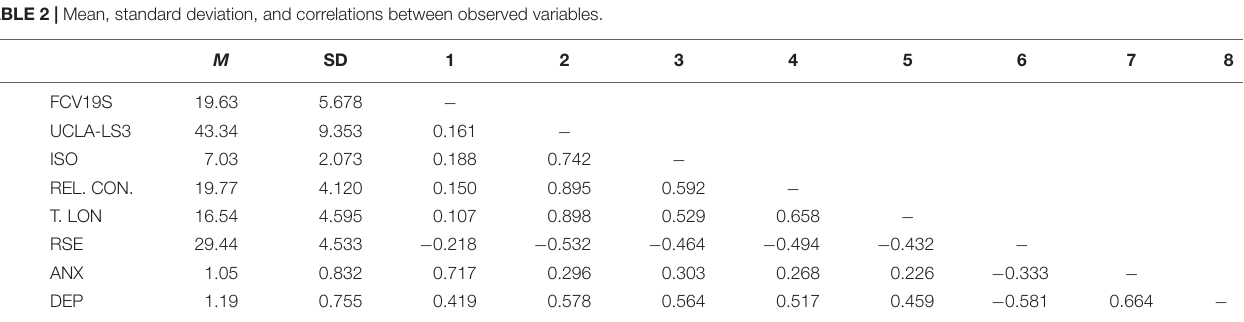
FIGURE 2 | Graphical representation of the full sequential multiple mediation model with two-related different predictors. TABLE 2 | Mean, standard deviation, and correlations between observed